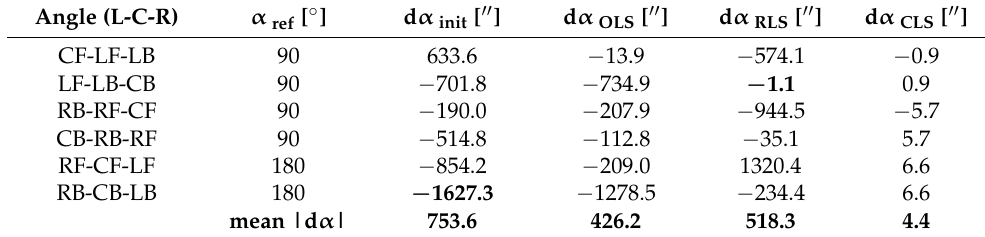
Table 4. The differences in angles in relation to the theoretical frame fixed values. Angle